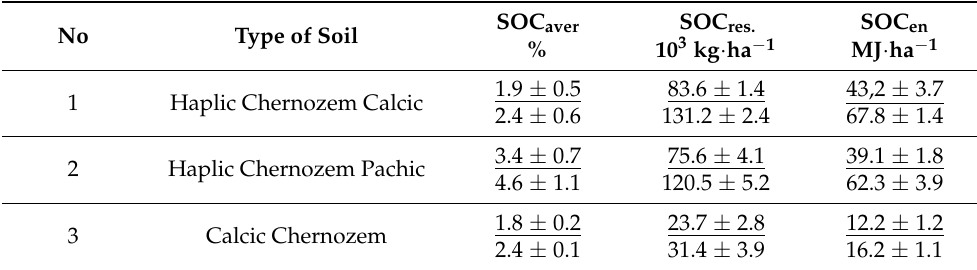
Table 3. Content reserves and energy content of SOC in the topsoil (0–30 cm) of regions no. 1–3 (the numerator represents the indicators for CT, in the denominator-VS). SOC aver SOC res. No Type of Soil % Haplic Chernozem